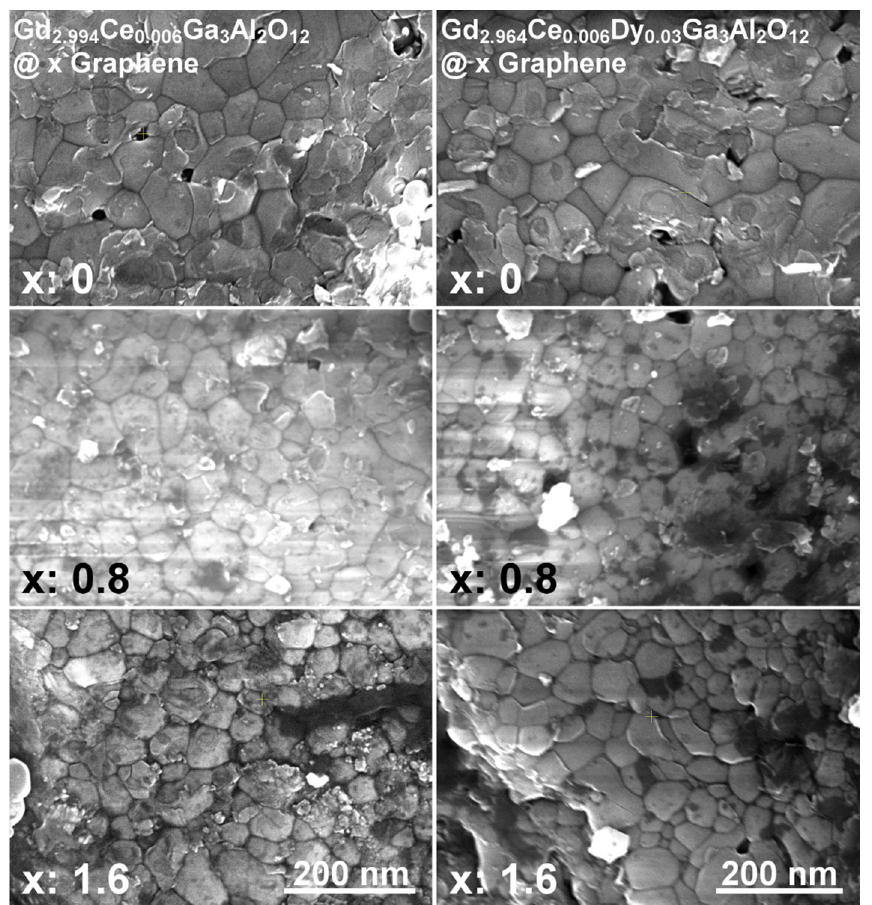
Figure 2. SEM images of Gd 2.994 Ce 0.006 Ga 3 Al 2 O 12 and Gd 2.964 Ce 0.006 Dy 0.03 Ga 3 Al 2 O 12 ceramics with different graphene content.